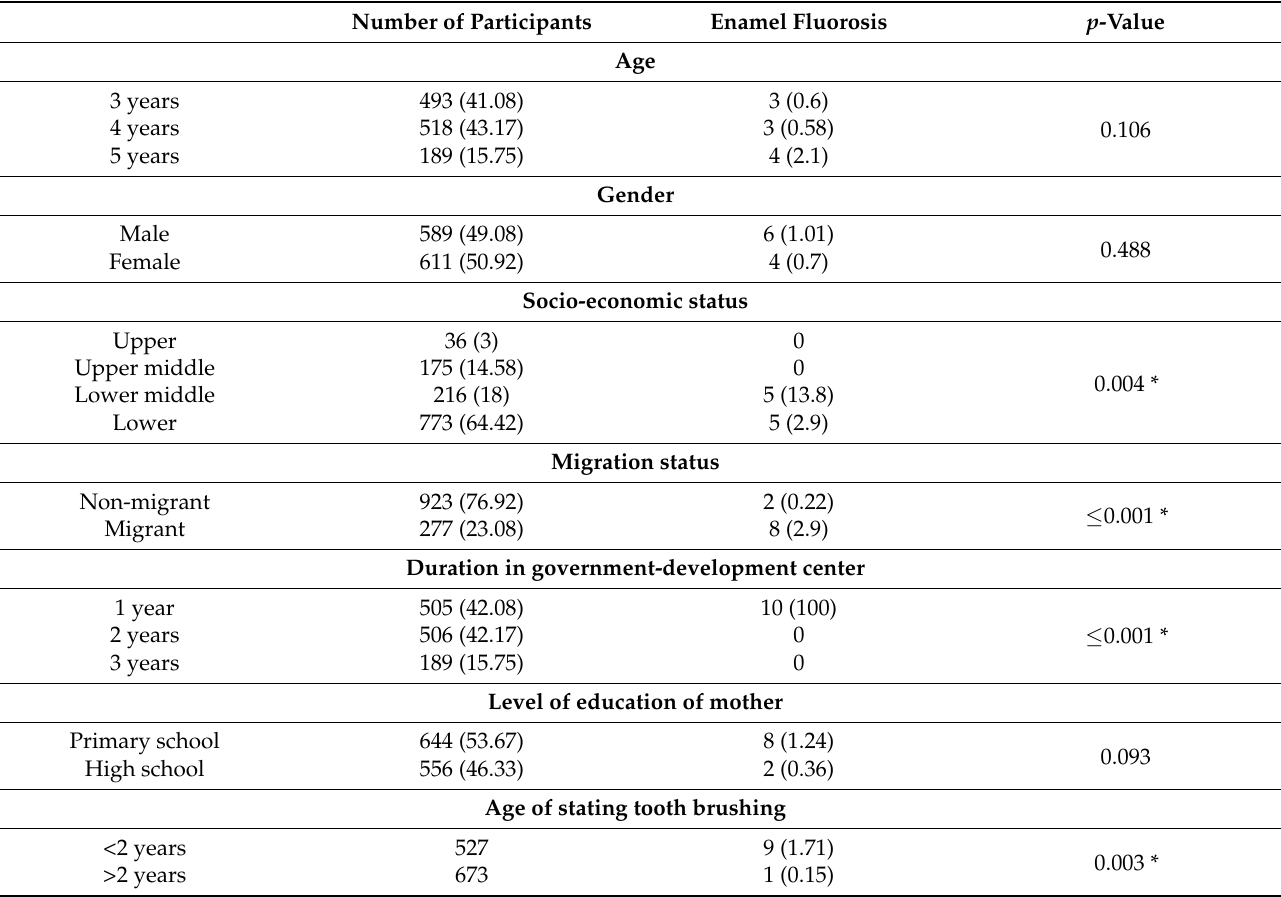
Table 1. Sociodemographic characteristics of children with enamel fluorosis. Number of Participants